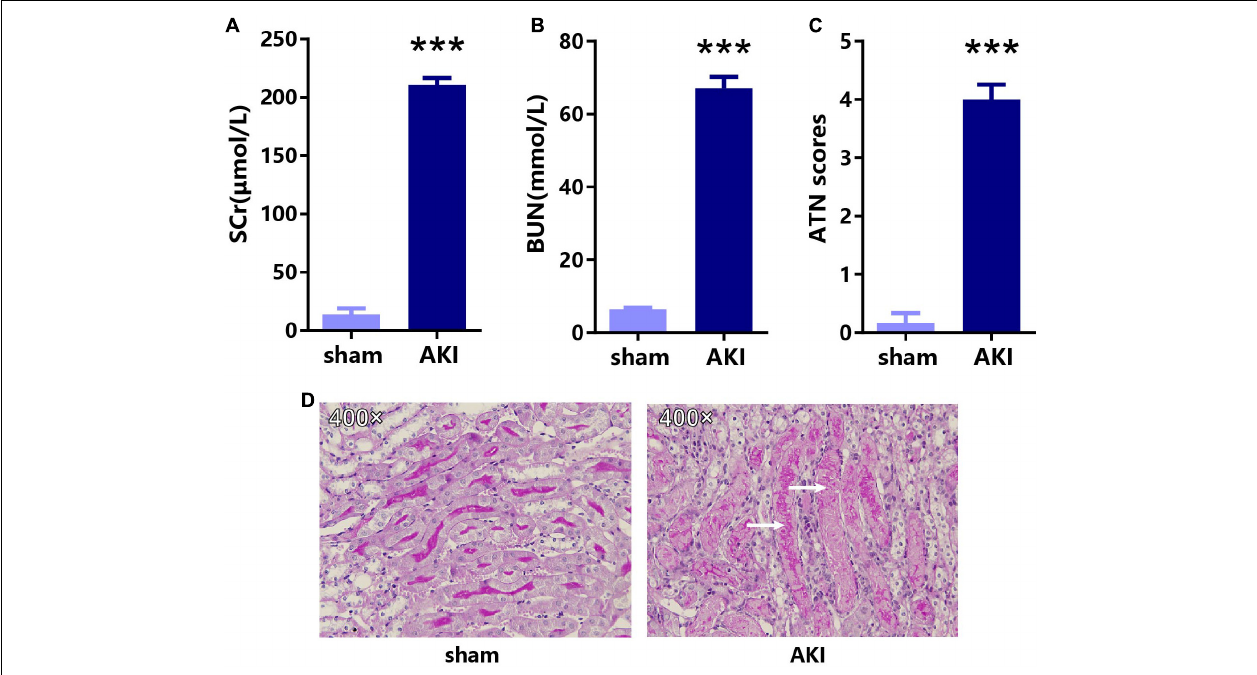
FIGURE 7 | The results of SCr, BUN, and ATN scores, and PAS staining in 24 h after IRI or sham surgery. The results of (A) SCr, (B) BUN, (C) ATN scores, and (D) PAS staining in AKI and sham groups. *** p < 0.001. SCr, serum creatinine; BUN, blood urea nitrogen; ATN, tubular necrosis; PAS, Periodic